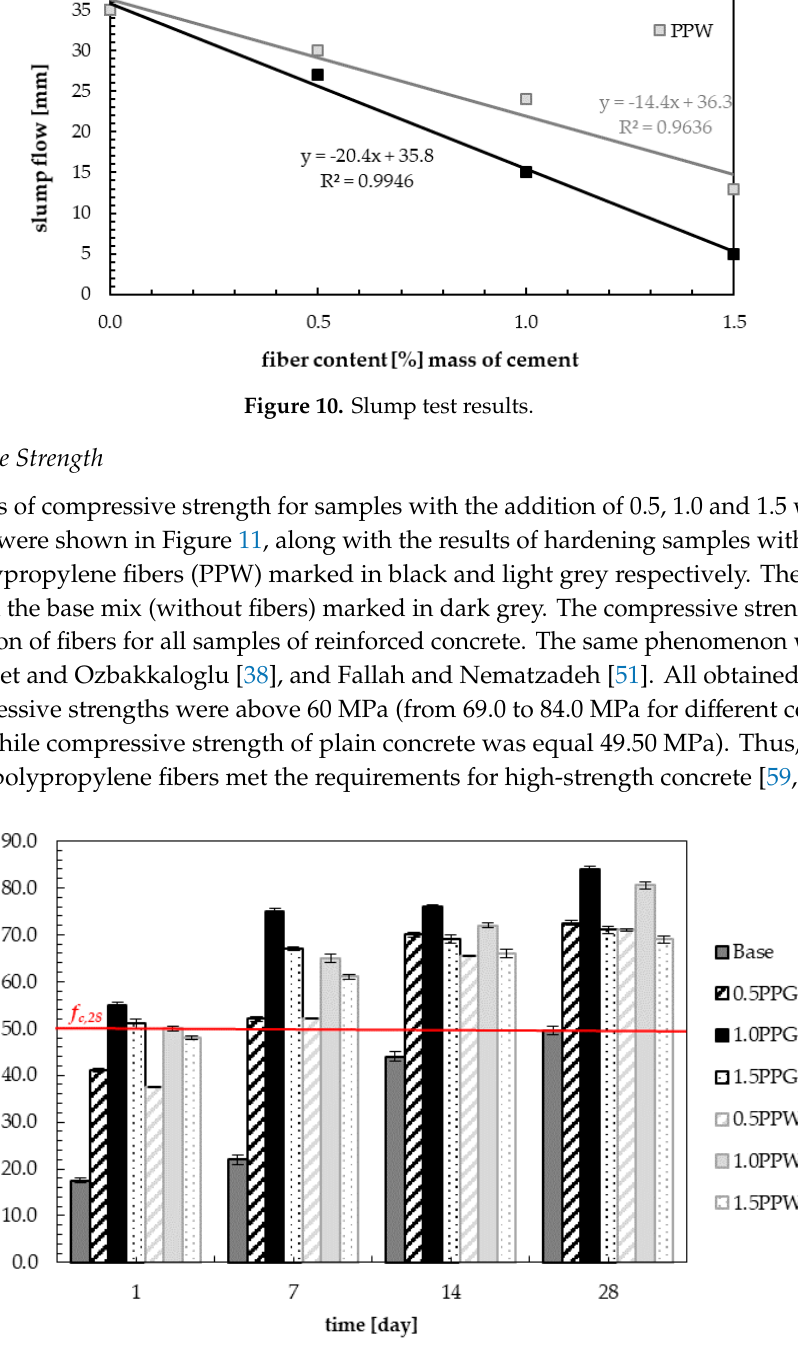
Figure 11. Compressive strength of samples with PPG and PPW during the curing process.